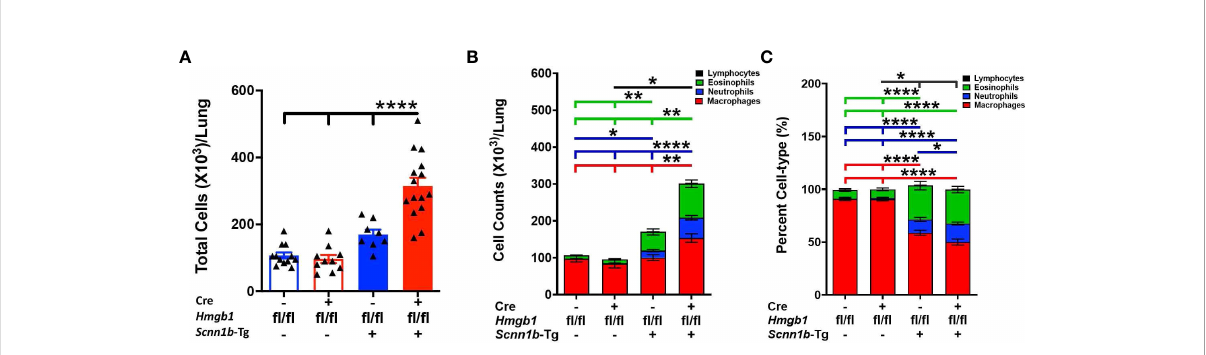
FIGURE 3 Airway epithelial cell-speci fi c deletion of HMGB1 modulates immune cell recruitment in airspaces of Tg+ mice. Total cell counts (A) are shown for Cre - /WT [blue open bar], Cre + /WT [red open bar], Cre - /Tg+ [solid blue bar], and Cre + /Tg+ [solid red bar] mice). Differential cell counts (B) and the relative percentages (C) are presented as stacked bar graph (macrophages [red bar], neutrophils [blue bar], eosinophils [green bar], and lymphocytes [black bar]). The signi fi cant differences are shown by horizontal lines of cell-speci fi c colors (macrophages [red line], neutrophils [blue line], eosinophils [green line], and lymphocytes [black line]). For enhanced clarity in the comparisons, these stacked graphs are replotted for individual cell types (Supplemental Figure 1). Error bars represent Mean ± SEM. One-way ANOVA followed by Tukey ’ s post hoc test was used for the statistical analysis. * p < 0.05, ** p < 0.01, **** p <